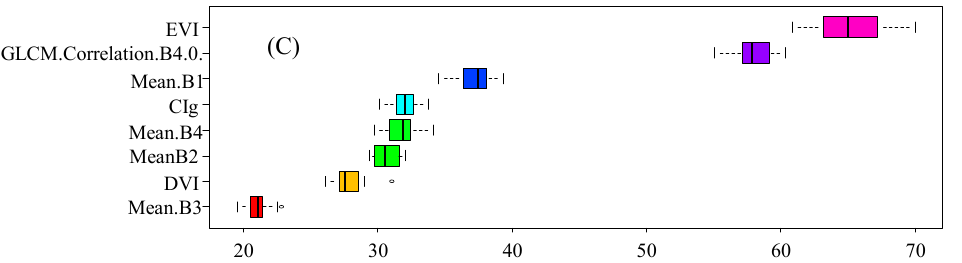
Figure 5. Ranking of image features based on the importance measure by %InSE (the percentage increase in the standard error) obtained from 20 runs of the RF for: ( A ) Landsat 8; ( B ) Sentinel-2; and ( C ) Pléiades-1.